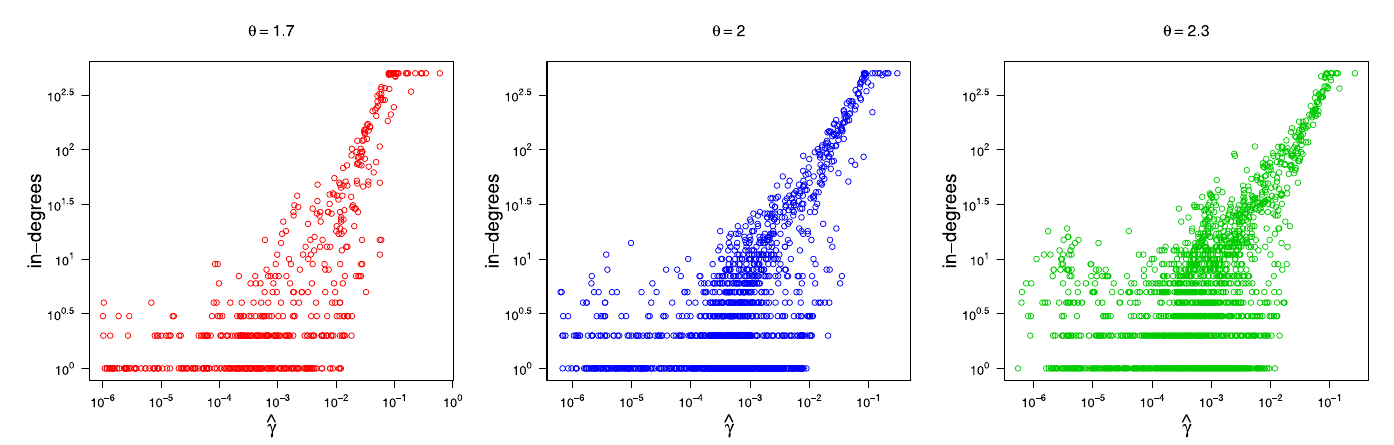
Fig 5. Scatter plots of the estimated popularity and true in-degrees.